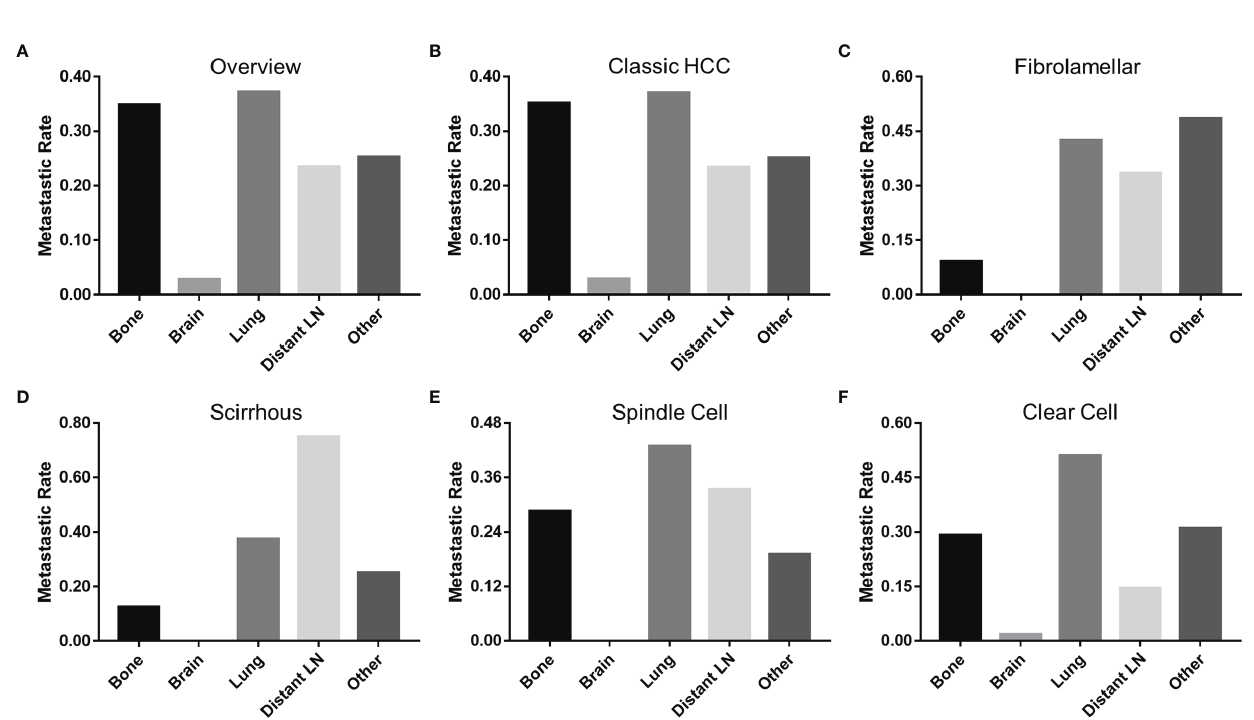
FIGURE 4 | Incidence of extrahepatic distant metastases at different sites of HCC. (A) All pathological subtypes, (B) classic HCC, (C) fi brolamellar carcinoma, (D) scirrhous carcinoma, (E) spindle carcinoma, and (F) clear cell carcinoma. HCC, hepatocellular carcinoma; LN, lymph